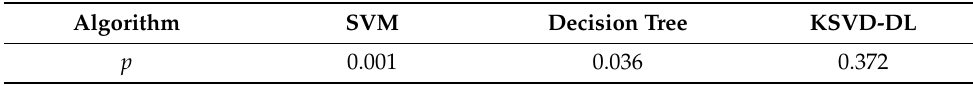
Table 4. The experimental results of the Nemenyi